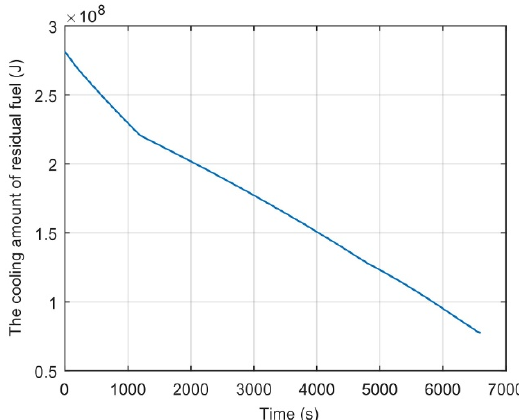
Figure 17. Real-time cooling amount of residual fuel inside unilateral fuel tank.